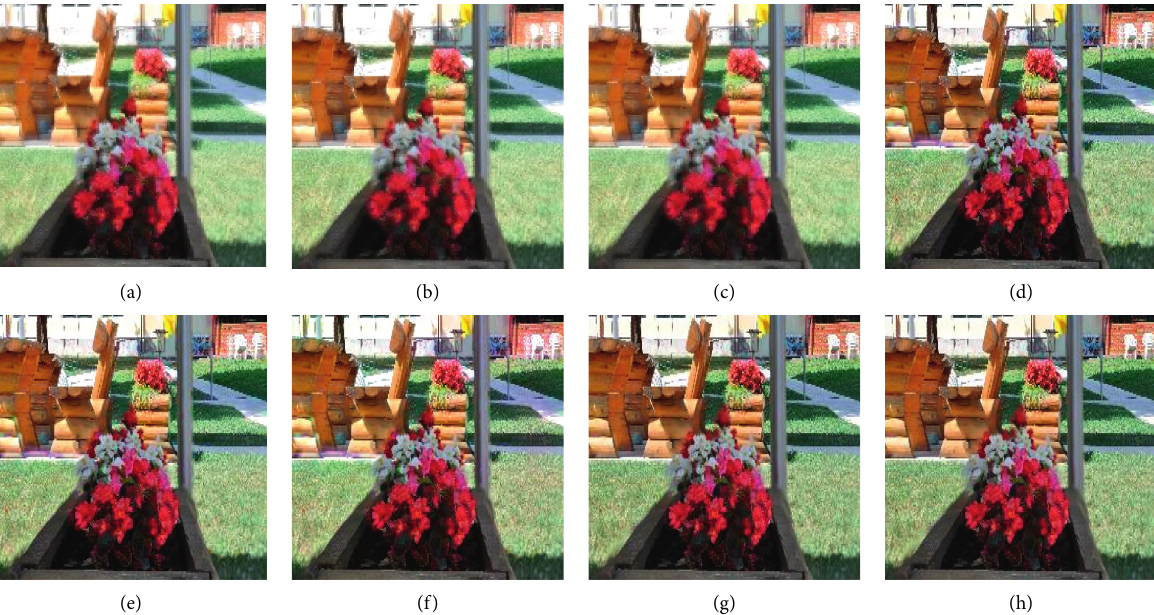
Figure 9: The fusion results of “Flower.” (a) PCNN. (b) Contourlet. (c) GAN. (d) Shearlet. (e) CSR. (f) SR-SML. (g) DCNN. (h)